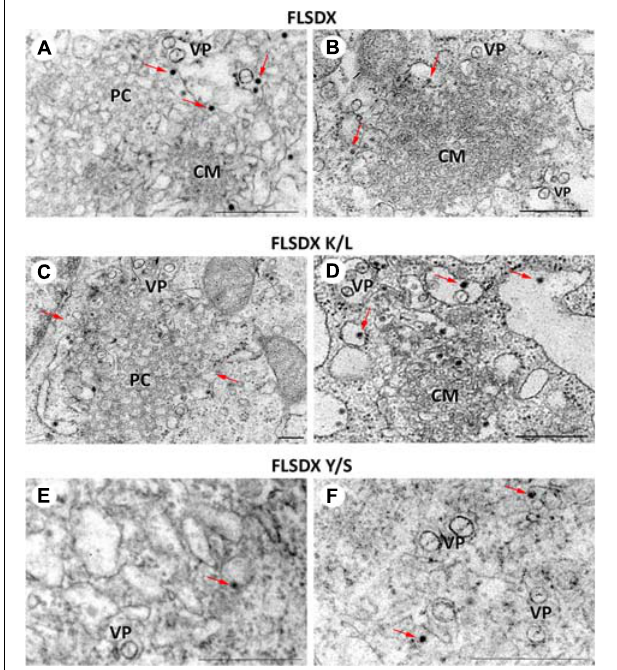
FIGURE 5 | Mutation of the CRAC domain within the WNV KUN NS4A proteins results in reduced membrane remodeling. Ultrastructural analysis of Vero cells electroporated with CRAC mutant FLSDX in vitro transcribed RNAs (FLSDX, A,B ; K/L mutant, C,D ; Y/S mutant, E,F ) at 48 h.p.i. Characteristic flavivirus-induced membrane structures convoluted membranes (CM) and paracrystalline arrays (PC) are only observed in FLSDX- and K/L mutant-electroporated cells. However, vesicle packets (VP) and virus particles (arrows) are observed in all cells. Magnification bars represent 200